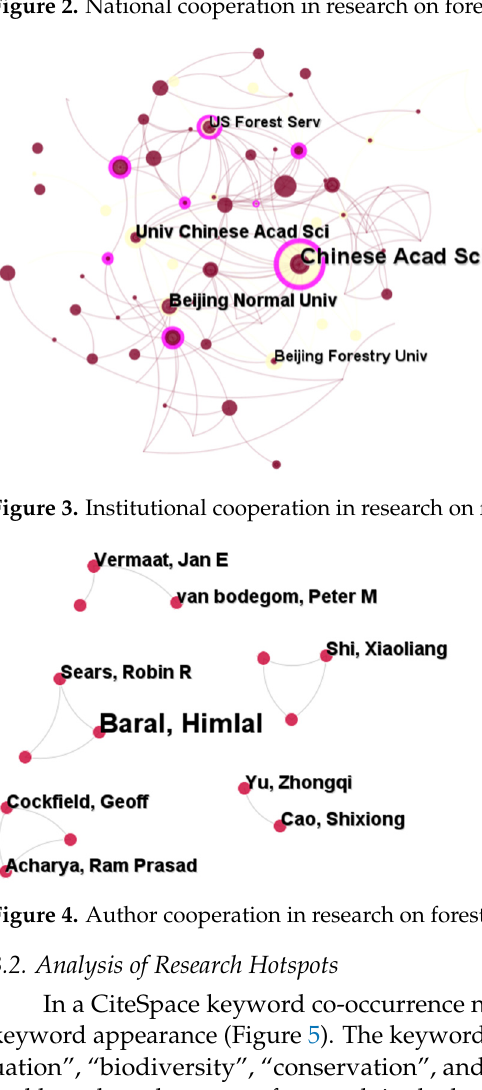
Figure 4. Author cooperation in research on forest ecosystem services among countries.